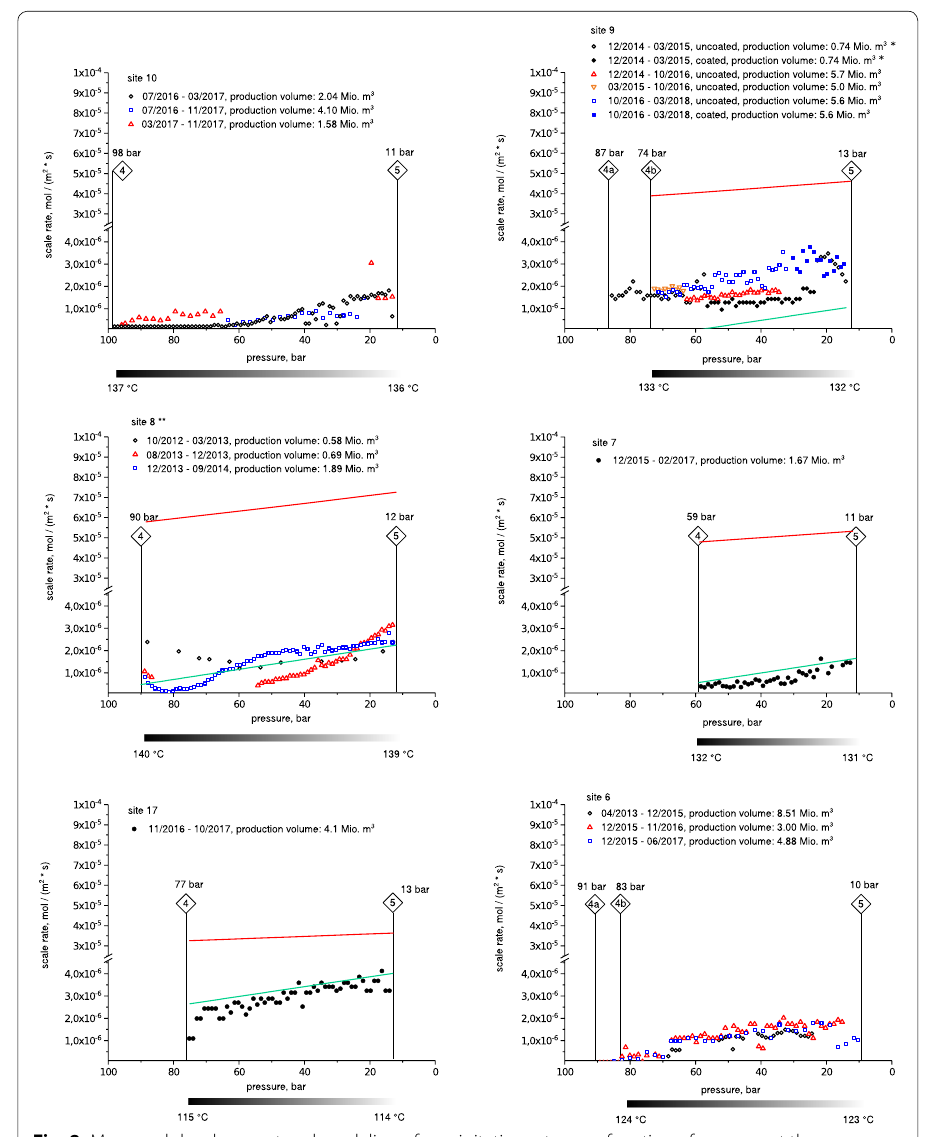
Fig. 8 Measured development and modeling of precipitation rates as a function of pressure at the investigated facilities with the indication of investigated time period, produced volume of geothermal water, fluid temperature, and modeling points. Red lines: scale rate modeled with existing hydrochemical models (PHREEQC). Green lines: scale rate modeled based on experimental regression between SI (x) and scale rate (f(x) - 4.86 · 10 − 6 2.96 · 10 − 5 · x) at the wellhead. *Scale thickness from Wanner et al. (2017) = + implemented (site 9), **Scale thickness based on data from Herbrich (2016) (site